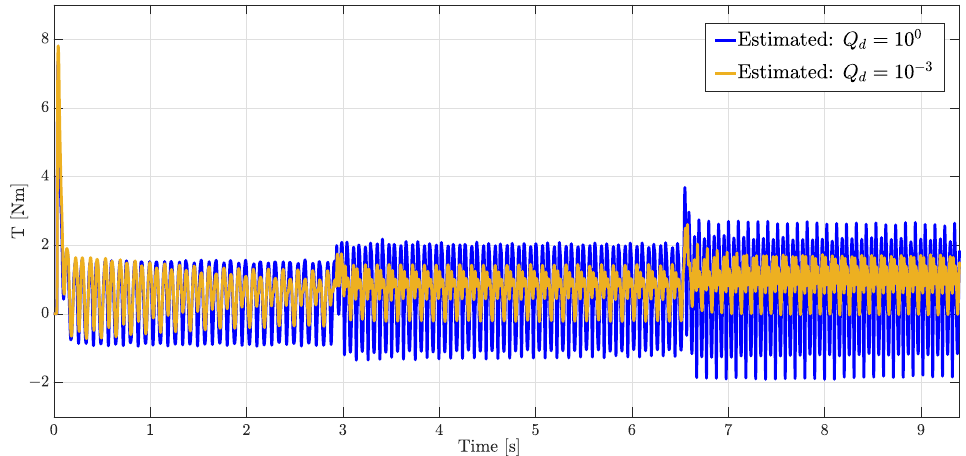
Figure 10. Comparison of the estimated motor torque using two different values of process covariance Q d of the augmented